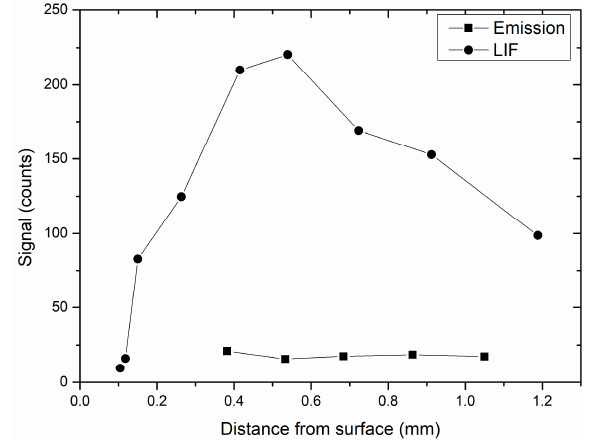
Figure 11. Vertical profiles of LIF and emission signals originating from the droplet observed in Figure 10. Signal averaged over a 3 × 3 pixel box on both LIF and emission images along the height.